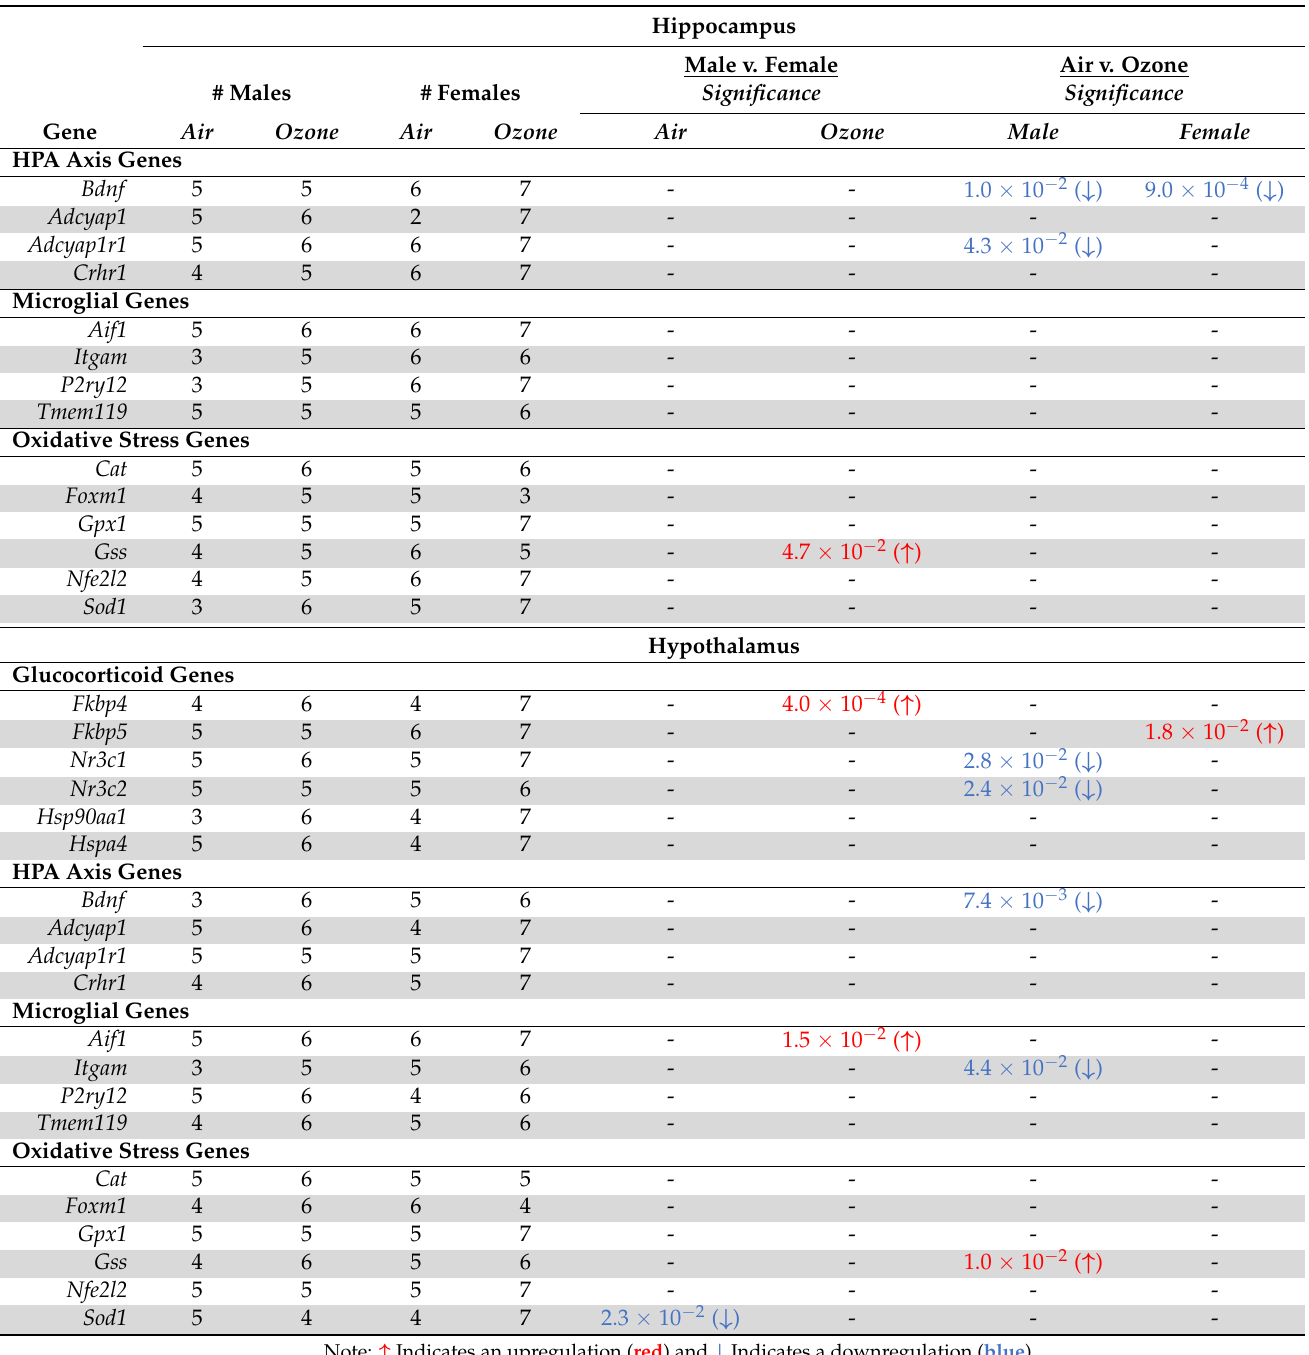
Note: ↑ Indicates an upregulation ( red ) and ↓ Indicates a downregulation ( blue